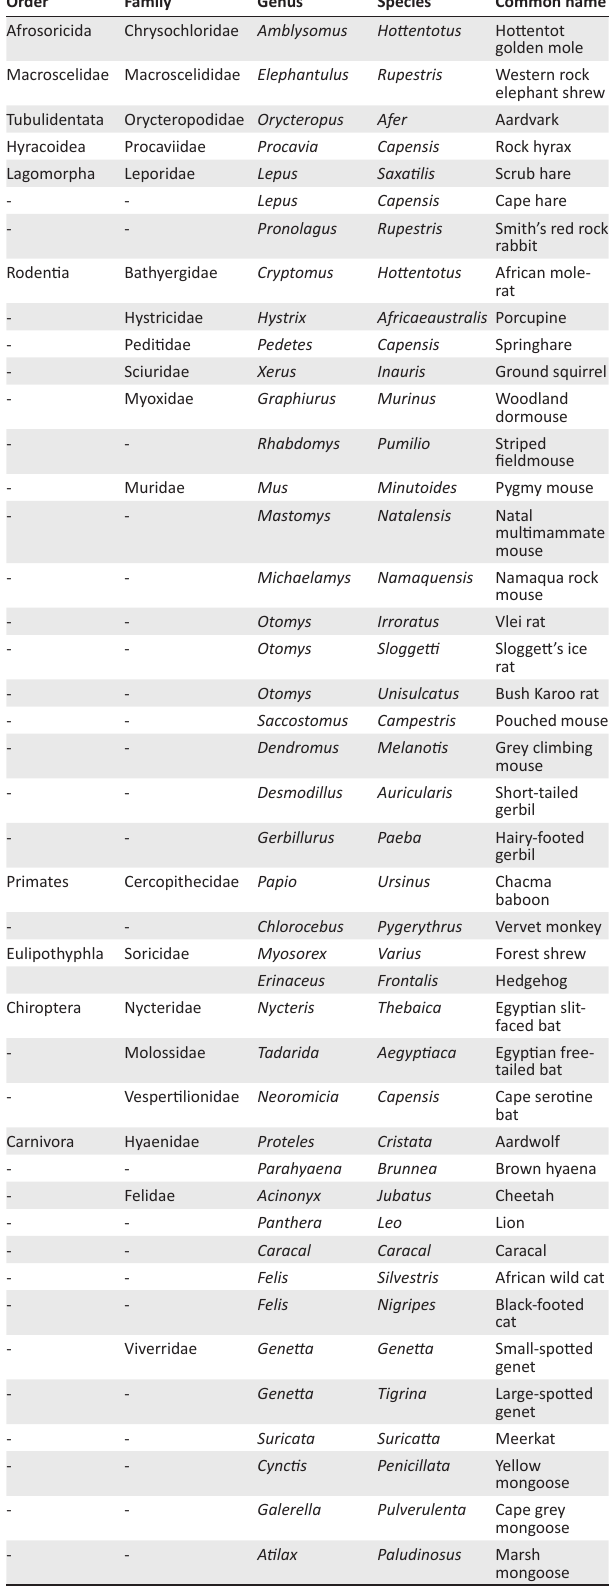
TABLE 1-A1: The updated (2020) checklist of 68 mammal species in the Mountain Zebra National Park, Eastern Cape, South Africa. See text for details on the criteria used for inclusion.